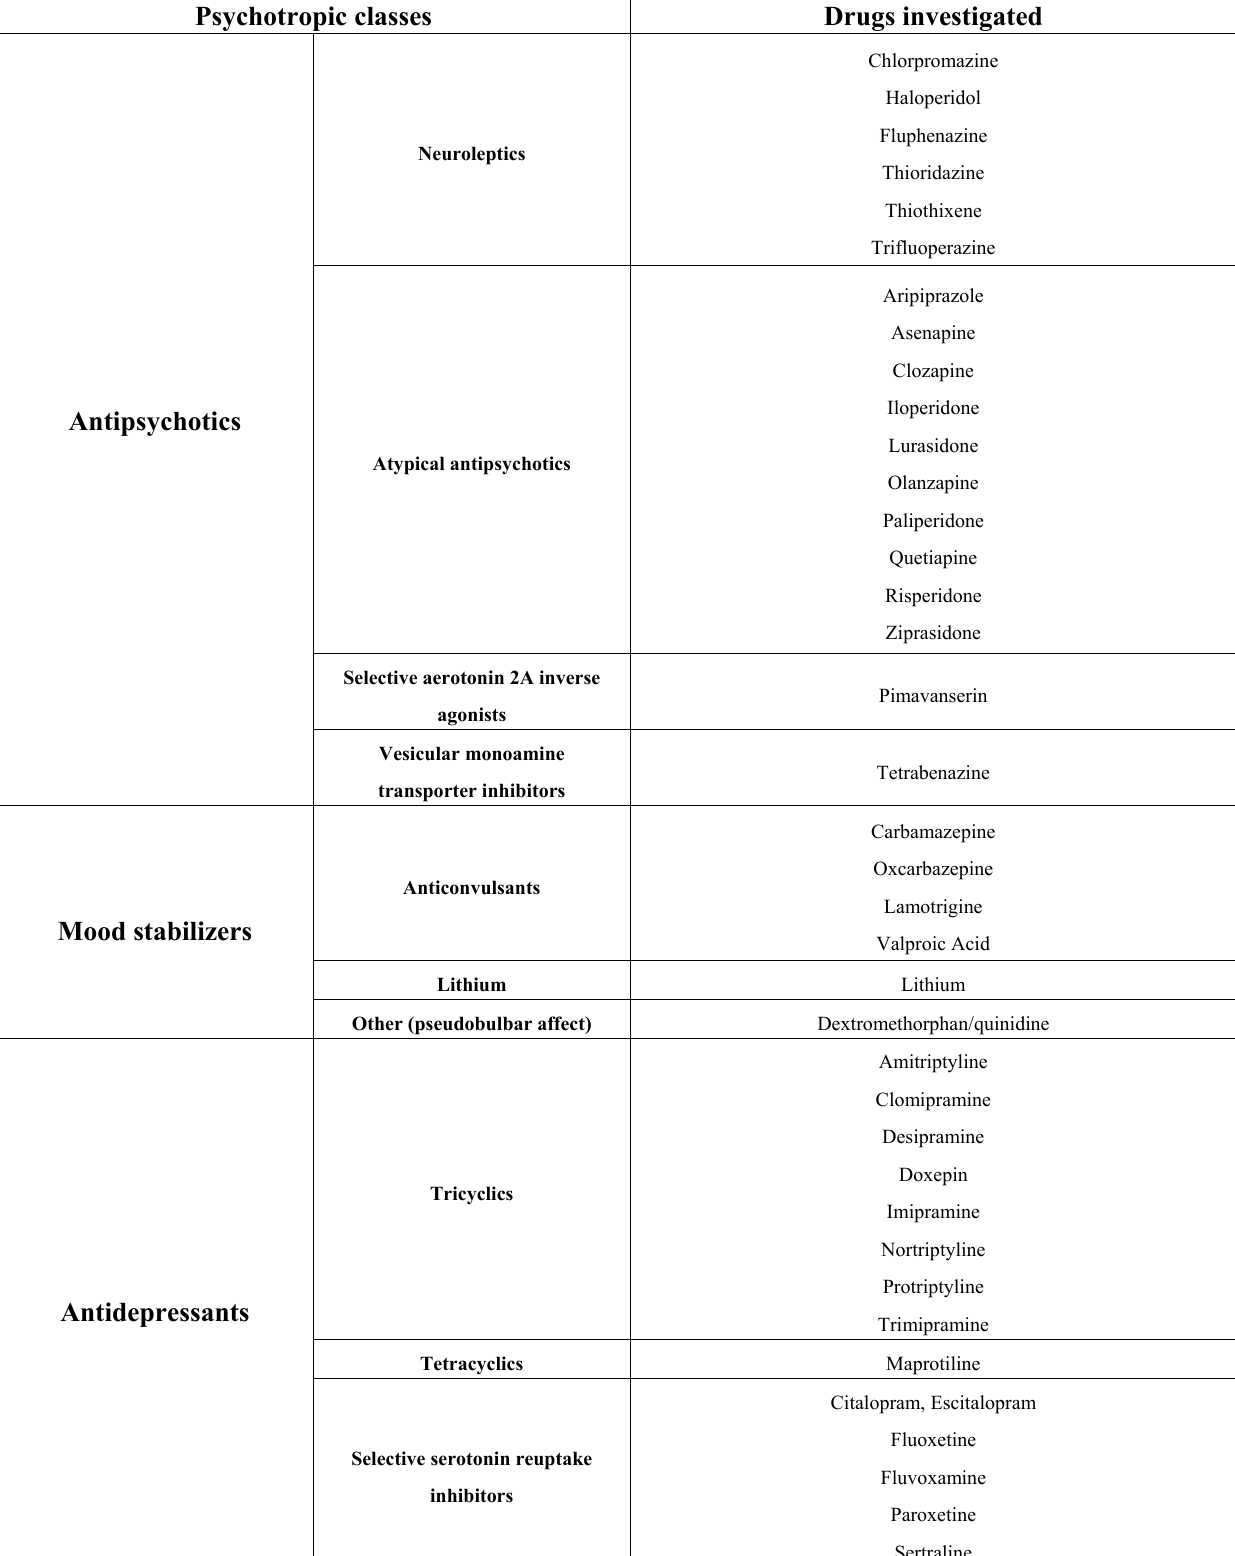
Table 1. Psychotropic classes and drugs